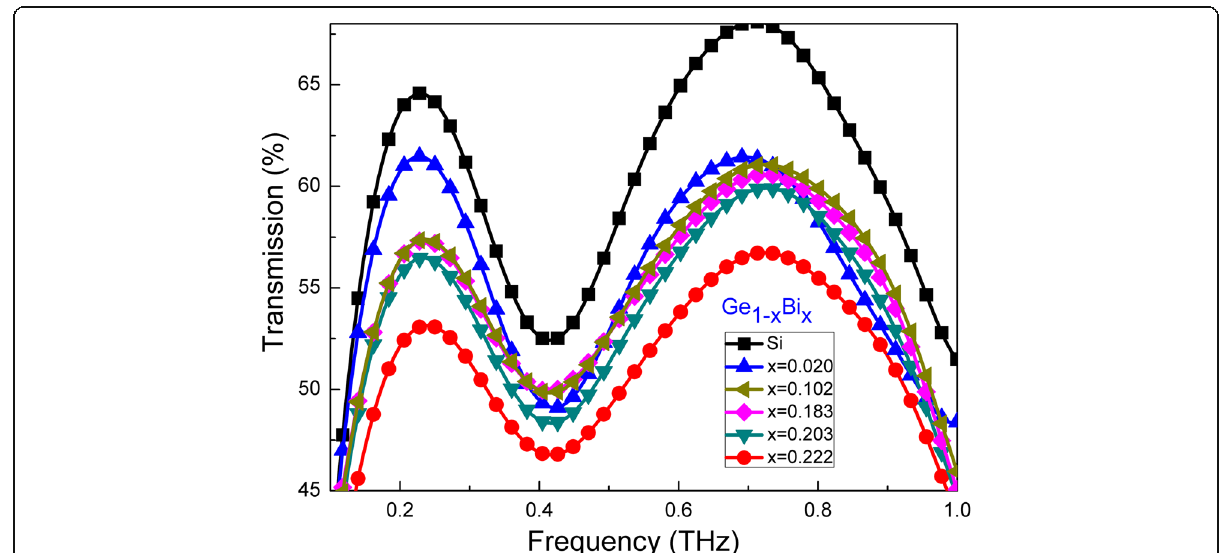
Fig. 7 THz transmission spectra of GeBi films with different Bi